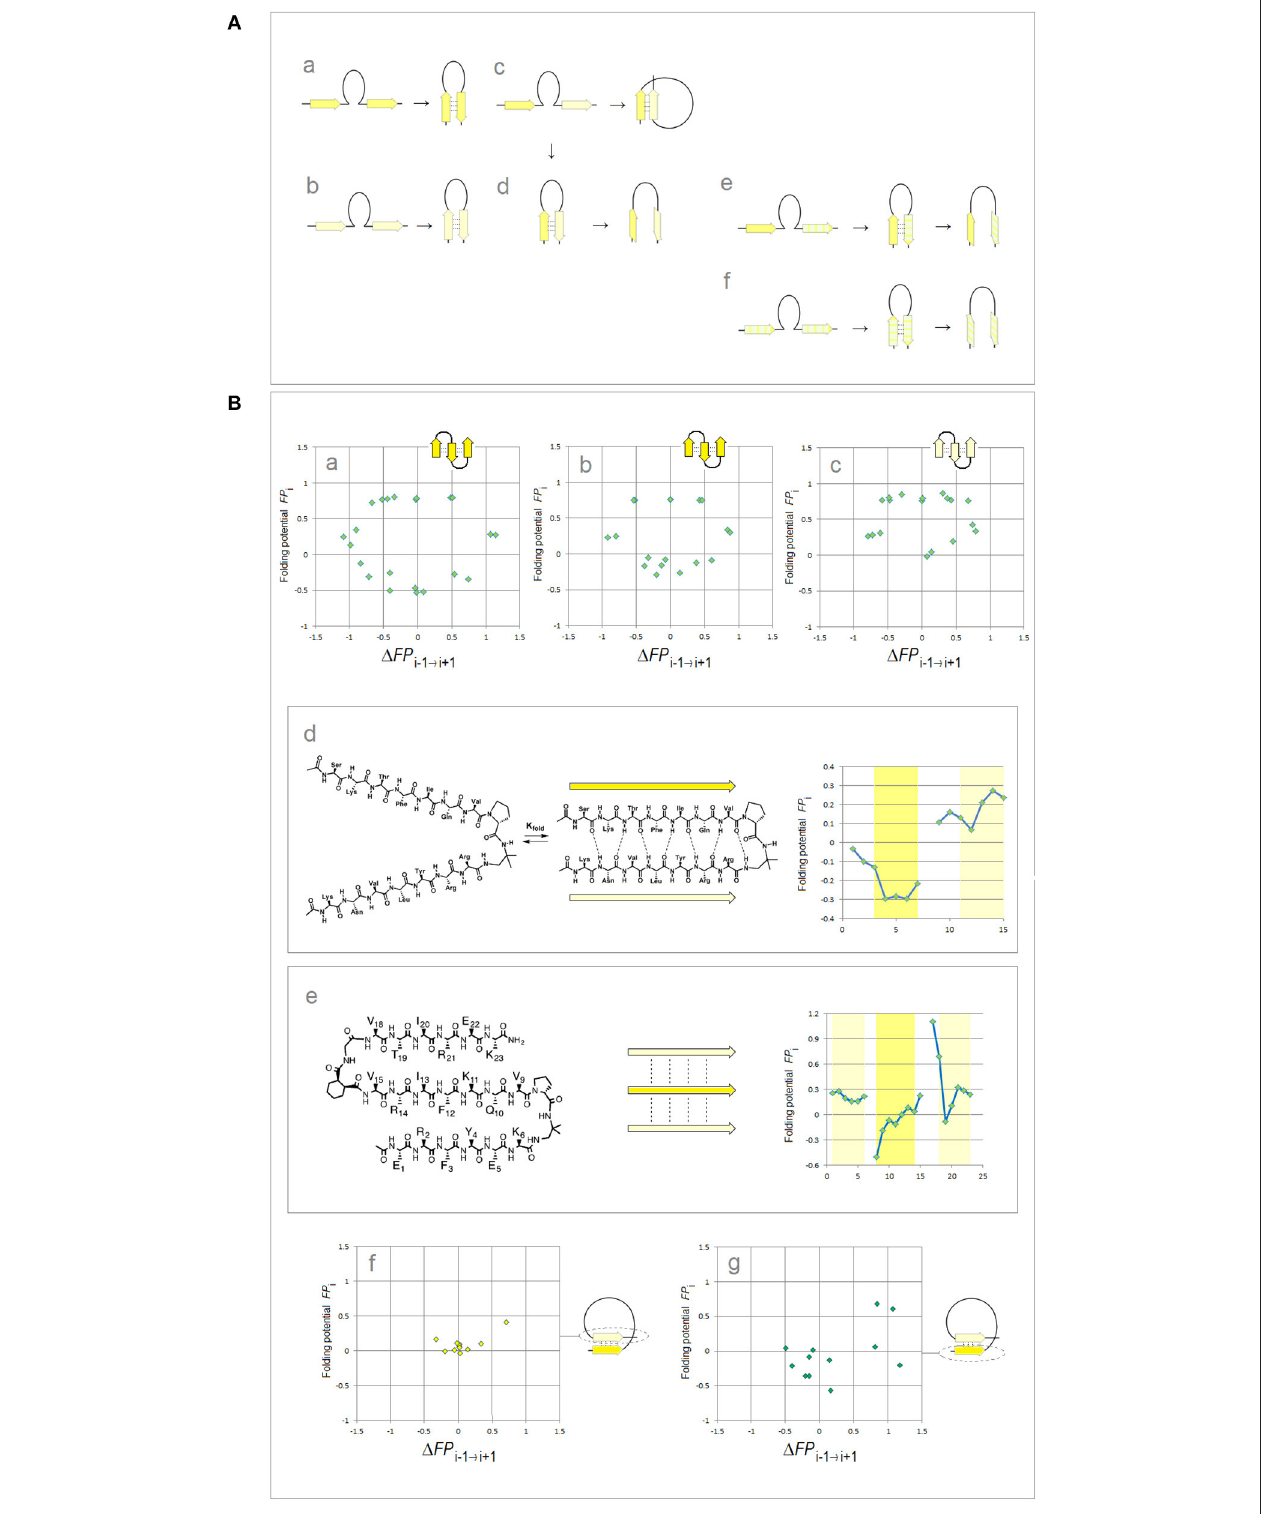
FIGURE 2 | Electronic configuration of the polypeptide backbone and molecular recognition in formation of β structure (Cieplak, 2017). (A) A model of alignment preferences in the complexes of the C 5 and C 7eq strands. The polypeptide segments comprising two consecutive strands form stable β -hairpins (antiparallel